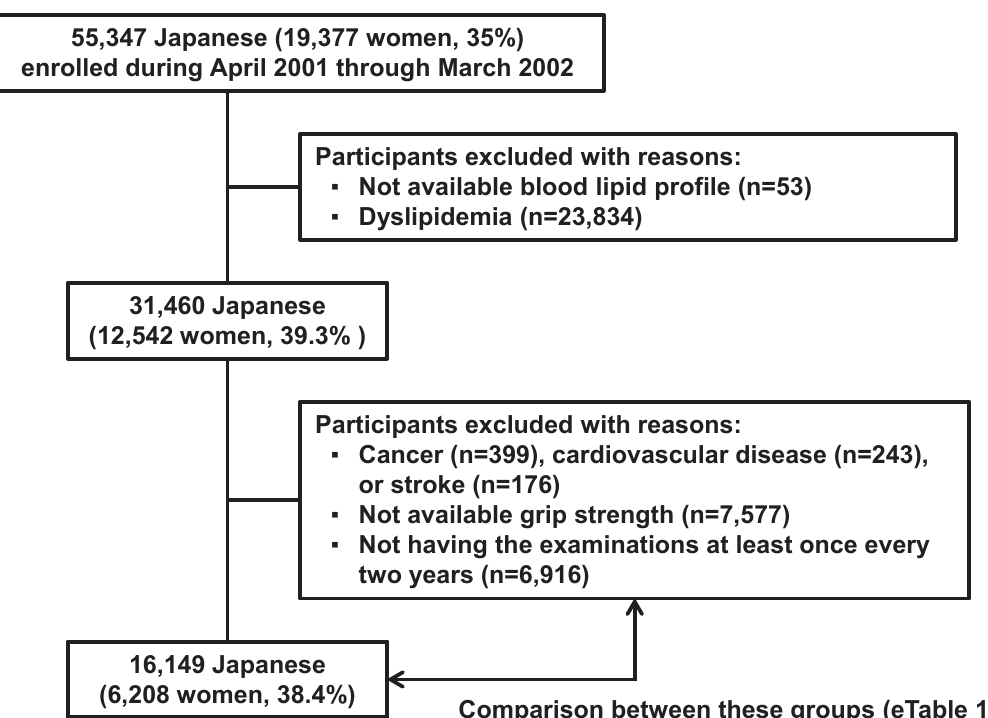
Figure 1. Flowchart of the selection of study